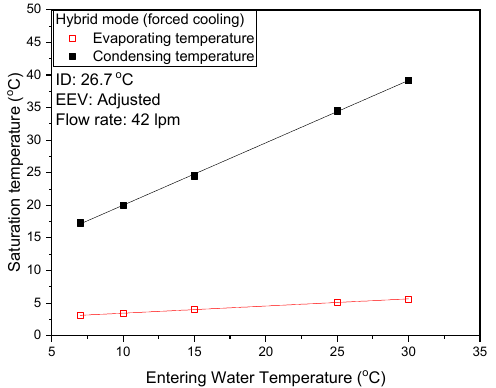
Figure 17. Saturation temperatures according to EWT in hybrid mode.